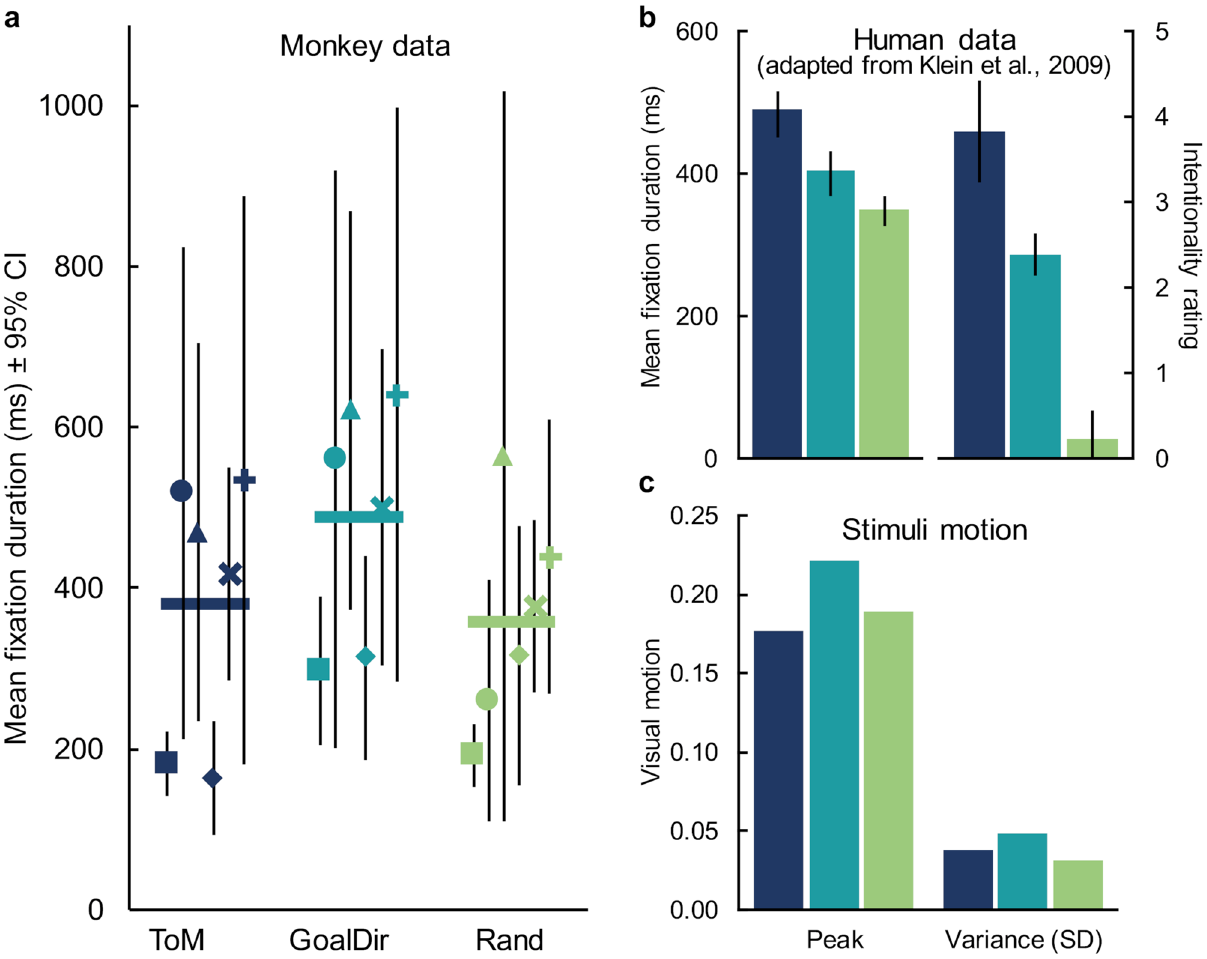
Figure 2. Monkeys did not show longer fixations for ToM videos. ( a ) Monkeys’ fixation durations as a function of animation category. Each thick horizontal line is the group mean fixation duration and each symbol represents an individual monkey’s mean fixation duration with ± 95% CI (ms). Abbreviations: ToM, Theory of Mind; GoalDir, Goal Directed; Rand, Random. ( b ) For comparison, humans’ fixation durations (± 95% CI) and intentionality ratings (± SD) as a function of category. Adapted from Klein et al. 8 . ( c ) Peak visual motion, left, and standard deviation in visual motion, right, of the animations as a function of category. Visual motion was calculated as in 39